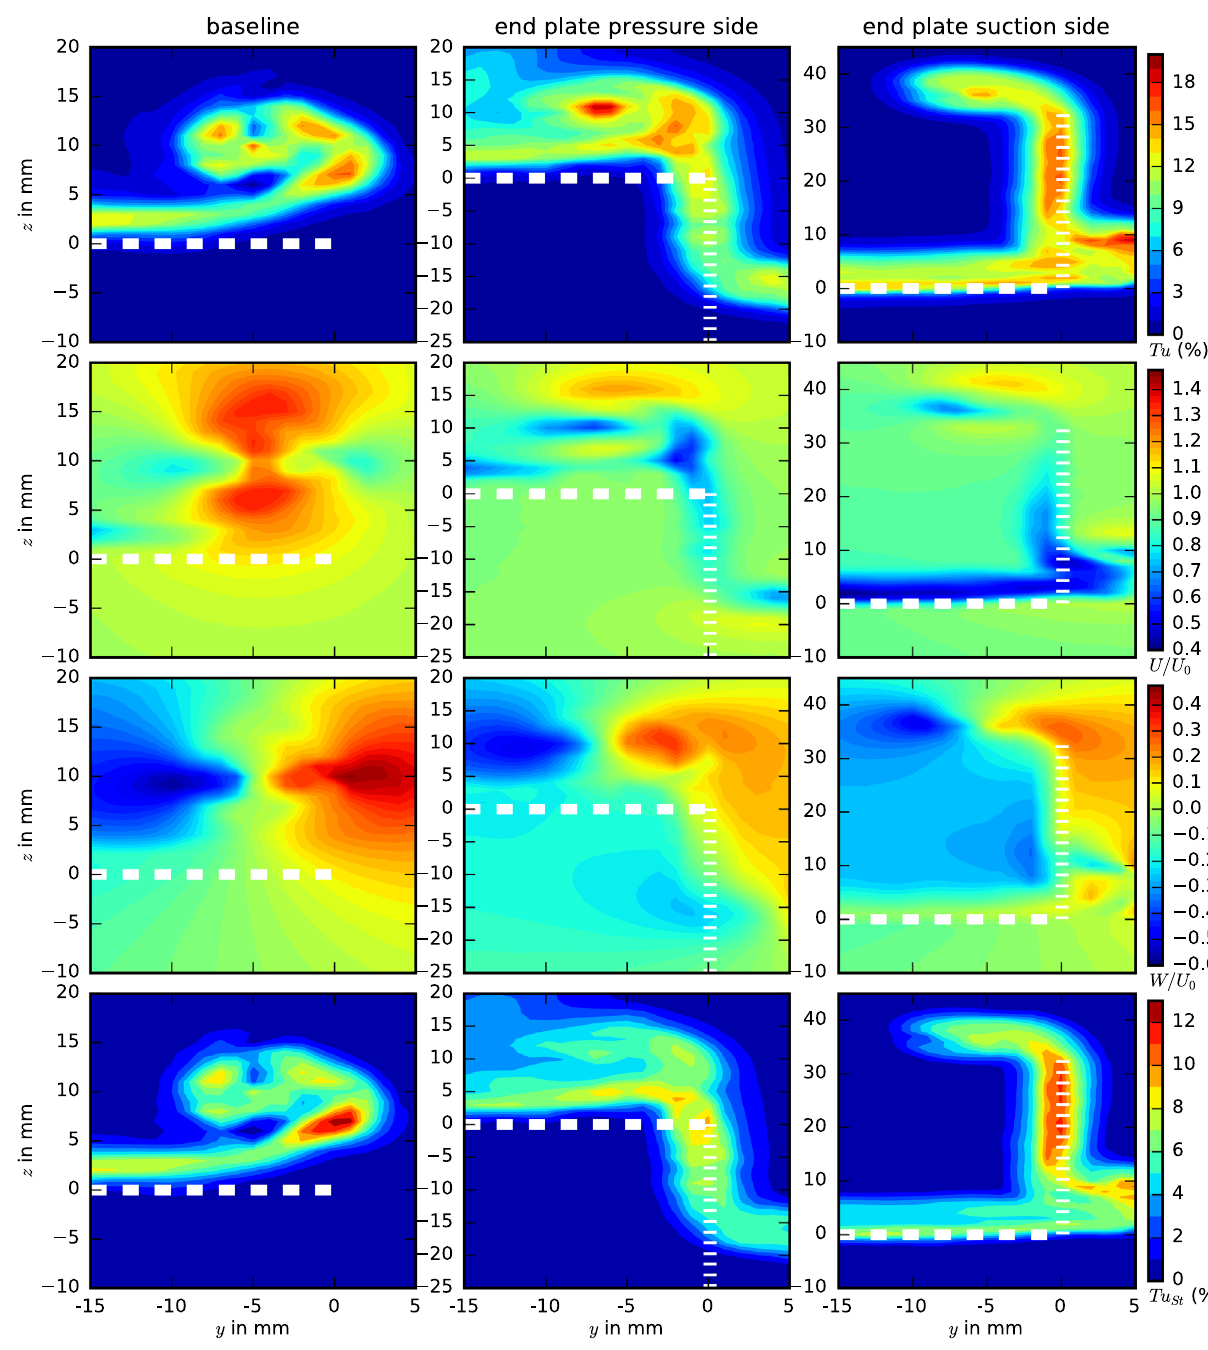
Figure 8. Turbulence intensity Tu , mean streamwise velocity U , mean upwash velocity W and turbulence intensity Tu St frequency fi ltered from St = 8 to St = 18, 15 (cid:1) angle of attack, Re = 150,000: baseline (left), end plate pressure side (middle), end plate suction side (right), (measurement plane located 0.1 chord lengths downstream of the airfoil (see Fig. 3b), white dashed line indicates trailing edge – vertical line indicates end plate (suction side